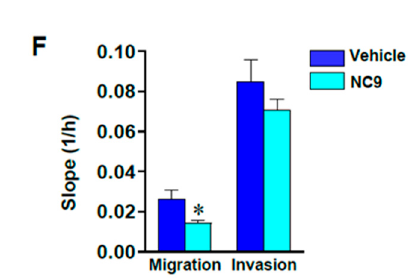
Figure 4. ( A ) Representative immunoblot analysis performed with the indicated antibodies on lysates from MDA-MB-231 cells cultured in the presence of vehicle or NC9. ( B ) Levels of TG2 as deduced from the analysis of chemiluminescence and normalized with β -Tubulin. ( C ) Representative phase-contrast images of MDA-MB-231 cells growing on glass dishes under the above reported conditions. Bar = 50 µ m. ( D , E ) Dynamic monitoring of migration and invasion, respectively, of MDA-MB-231 cells under the same experimental conditions. Cell index mean ± SD is reported, and the corresponding slope analysis is shown in ( F ). The data show the mean of three separate experiments performed in triplicate ± SD. * p < 0.05 versus